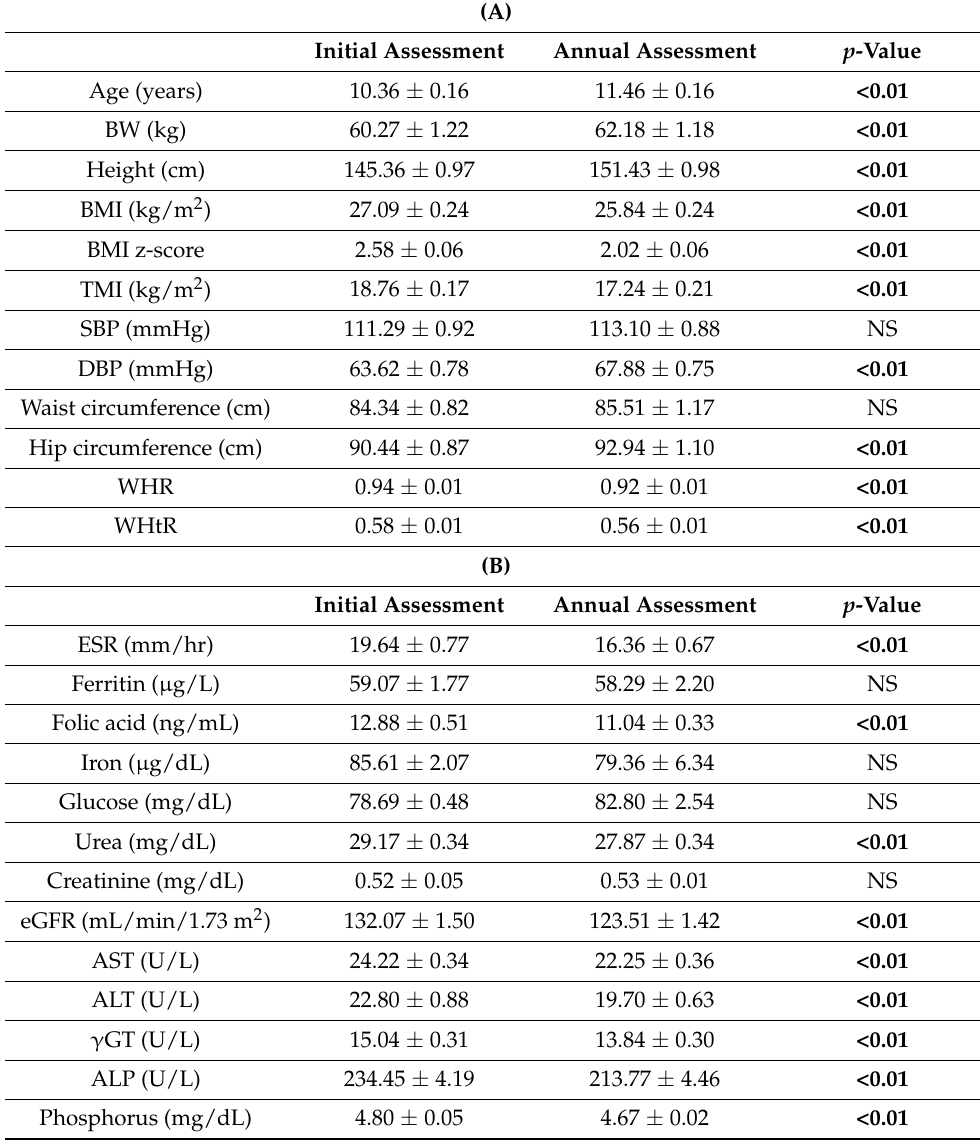
Table 3. Characteristics of all subjects at initial and annual assessment. ( A ) Clinical characteristics of all subjects. ( B ) Biochemical parameters. ( C ) Endocrinologic parameters. ( D ) Bone-derived proteins and adipokines. ( E ) Body composition